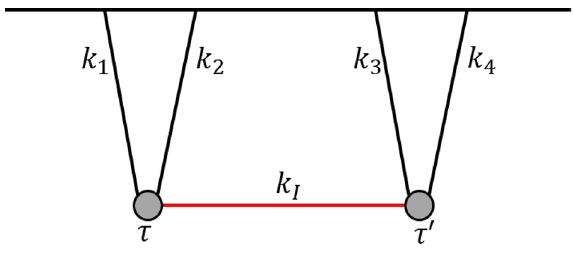
Figure 6 . Example 1: a direct massive scalar